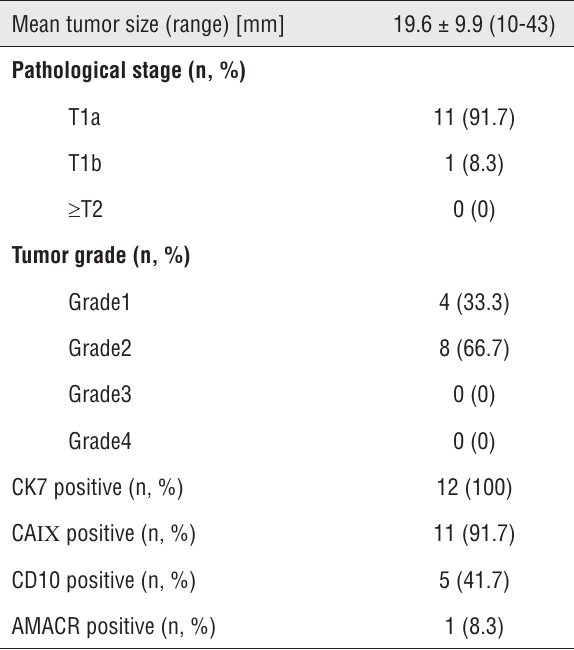
Table 3 - Histopathological findings. Mean tumor size (range)